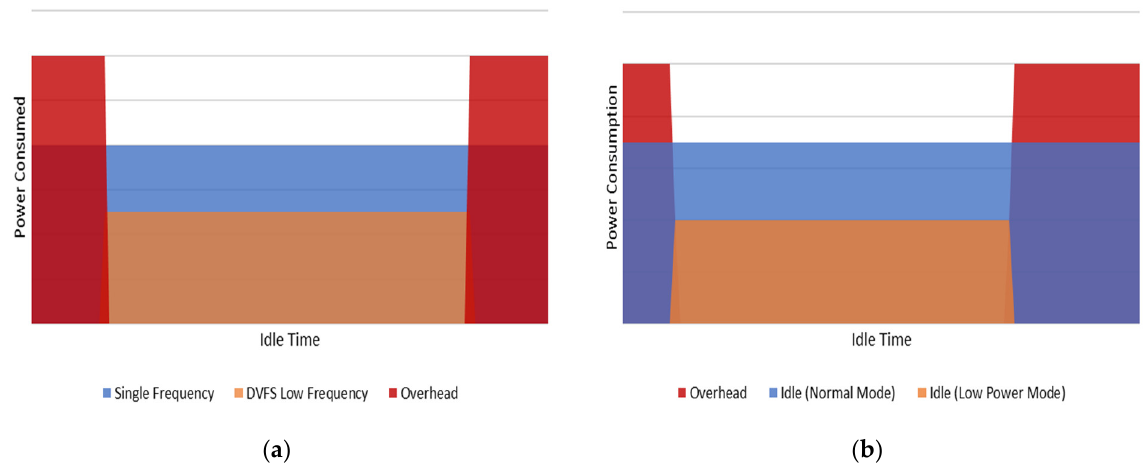
Figure 2. ( a ) Schematic diagram of the program execution energy consumption at a single frequency and DVFS. ( b ) Schematic diagram of the system idle energy consumption at a single frequency and using power-saving modes.